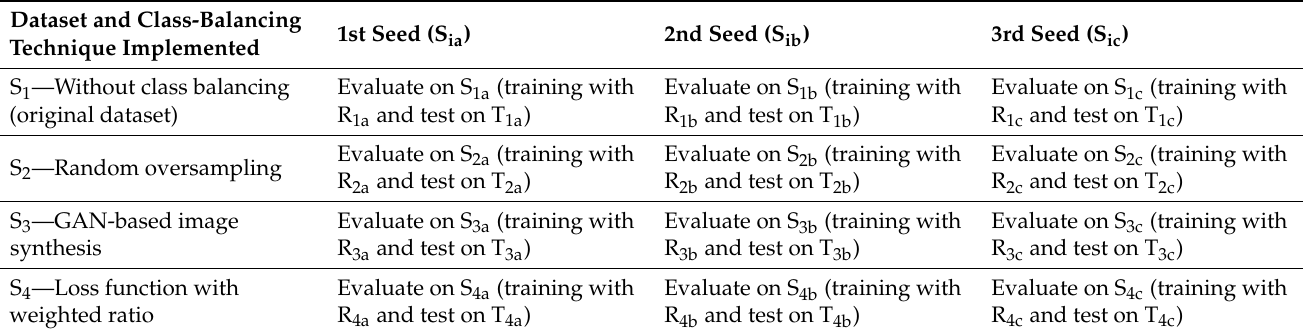
Table 2. Dataset manipulation and evaluation procedure for assessing the DeepARRNet model and different class-balancing methods.